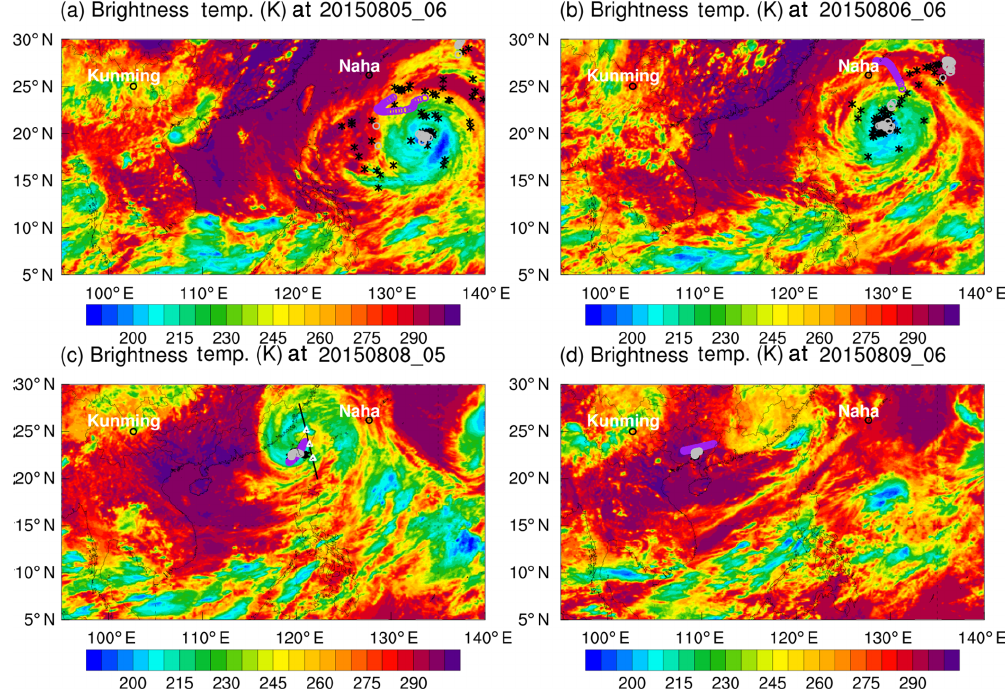
Figure 14. Brightness temperature from the FY-2G satellite on (a) 5 August, (b) 6 August, (c) 8 August, and (d) 9 August 2015 with backward trajectories (grey circles: ERA5 diabatic; black asterisk: ERA5 diabatic; purple circles: ERA-Interim diabatic) for air parcels with low ozone and low water vapour.